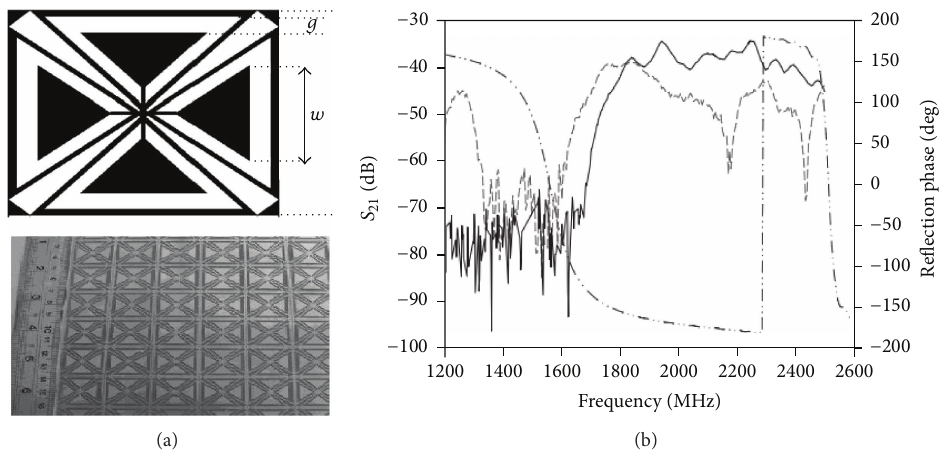
Figure 5: Wideband EBG: (a) single EBG element and an array (periodicity 22.8 mm). (b) Simulated reflection phase and measured transmission responses, [---- TM mode, —TE mode, – ⋅⋅ –, and reflection phase].